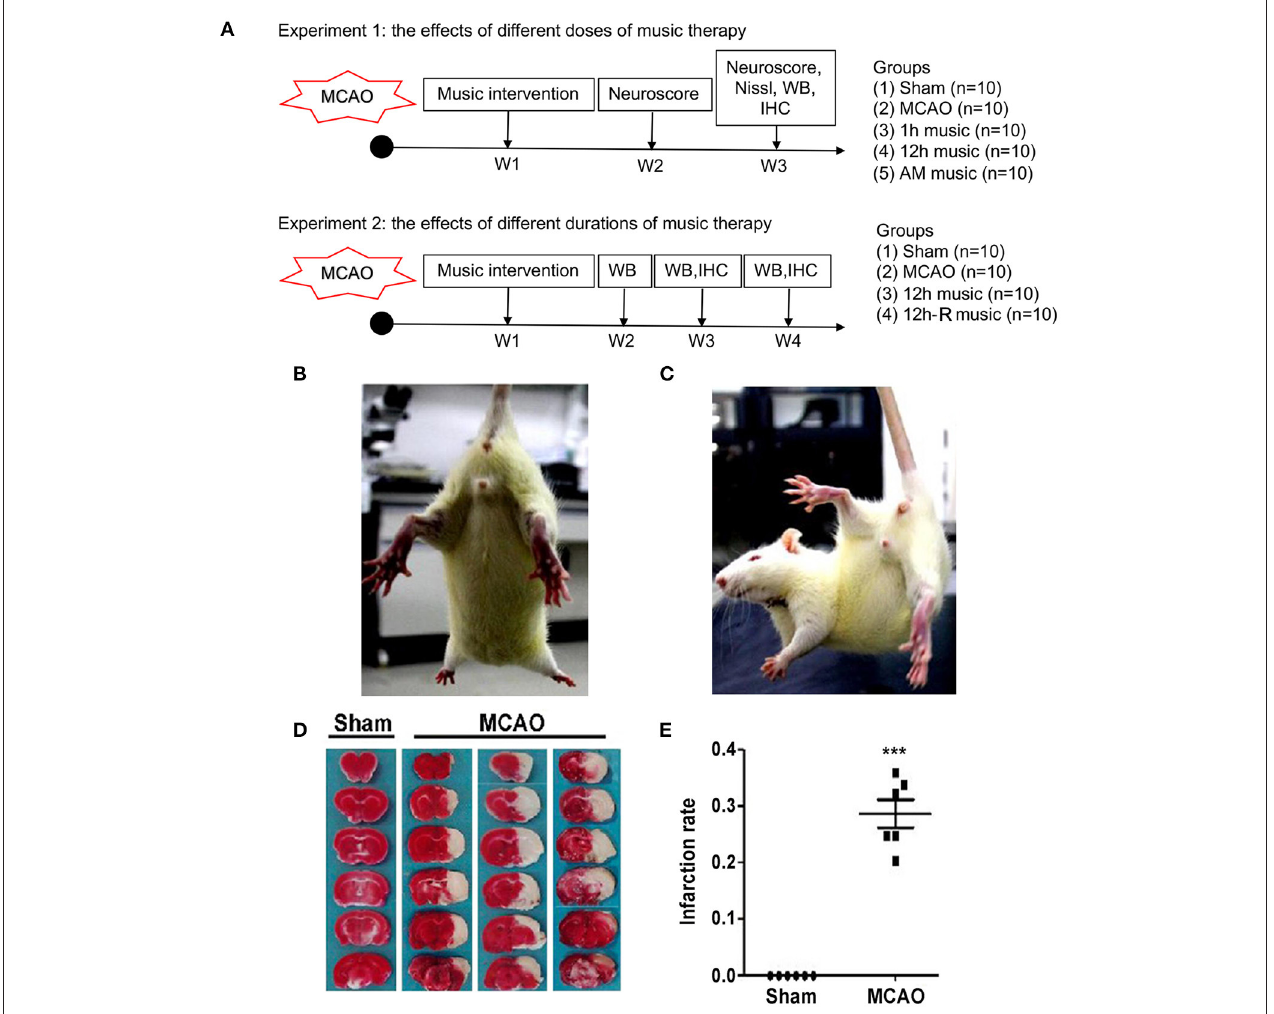
FIGURE 1 | Experimental design and verification of cerebral MCAO surgery in rats. (A) Experimental design and animal groups. (B,C) The postural reflex test for sham rat and MCAO rat. (D,E) Coronal sections of the sham and MCAO rats were stained with TTC. AM, accelerated music; IHC, immunohistochemistry; MCAO, middle cerebral artery occlusion; W, week; WB, western blot. *** p < 0.001. The asterisks represent significant difference compared with the sham group.